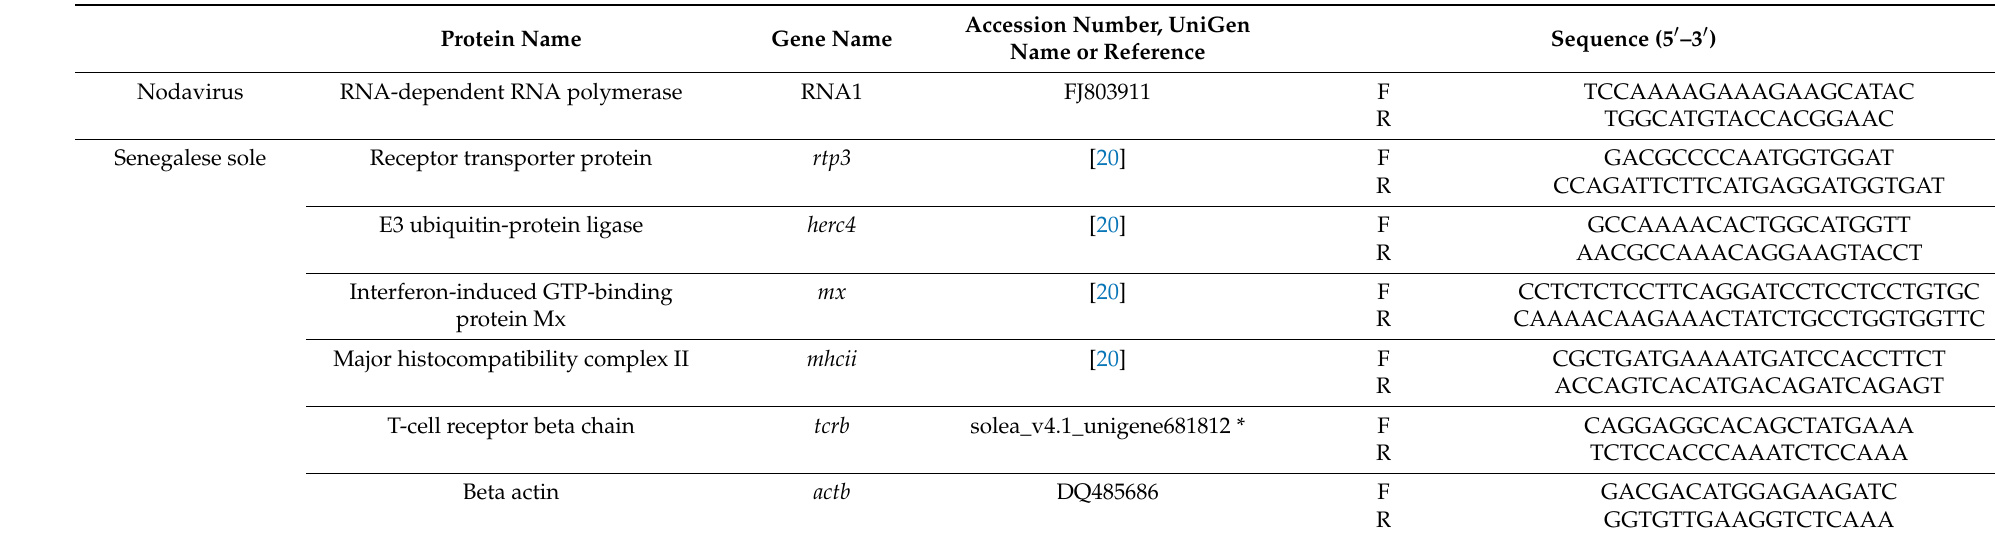
Table 1. Primer sequences used for gene expression